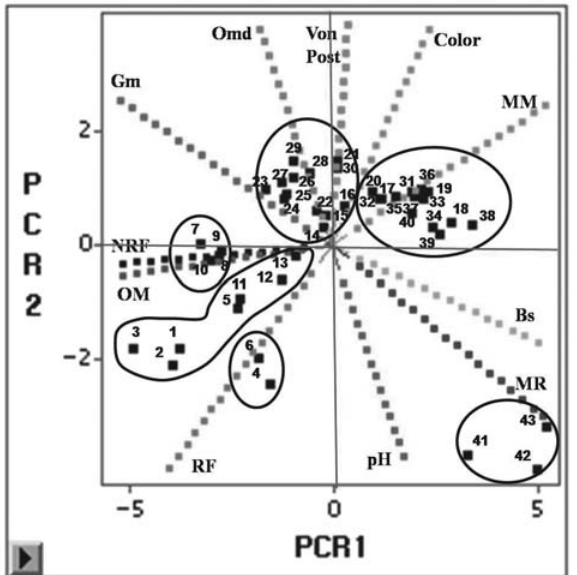
Figure 6. Grouping of samples collected in the study, based on the analysis of principal components. RF: Rubbed fiber content. OM: Organic